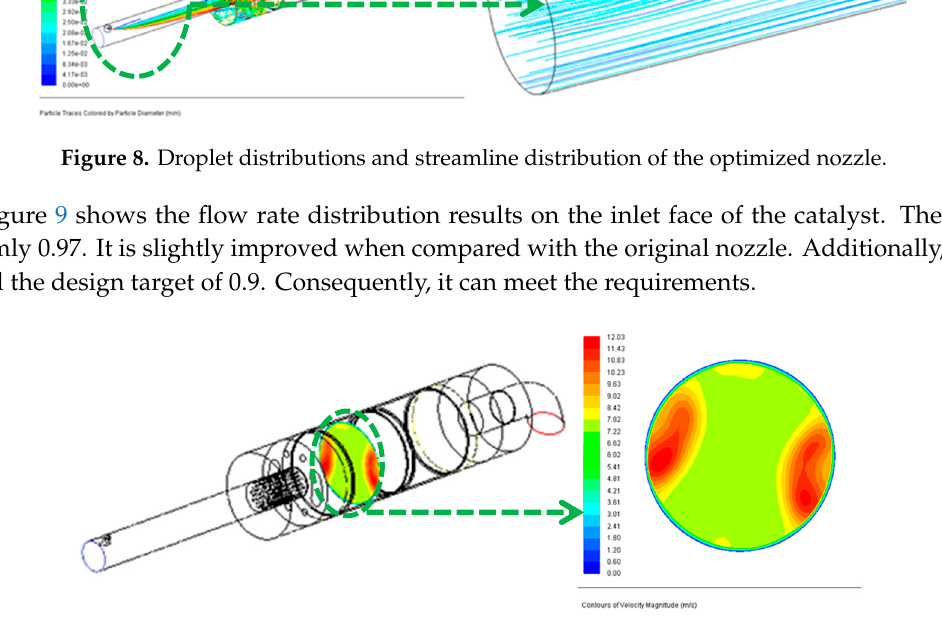
Figure 9. Flow velocity distribution of the face of the catalyst with the optimized nozzle (UI = 0.97, Operation Points 1).